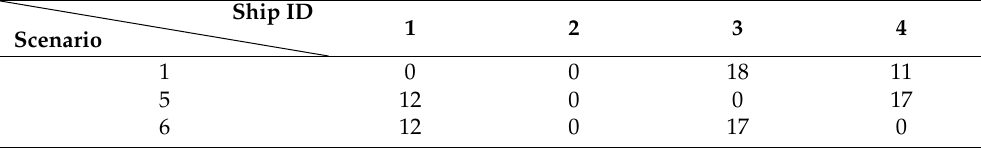
Table 15. Example 2—final cost for Strategy 2b (EUR).